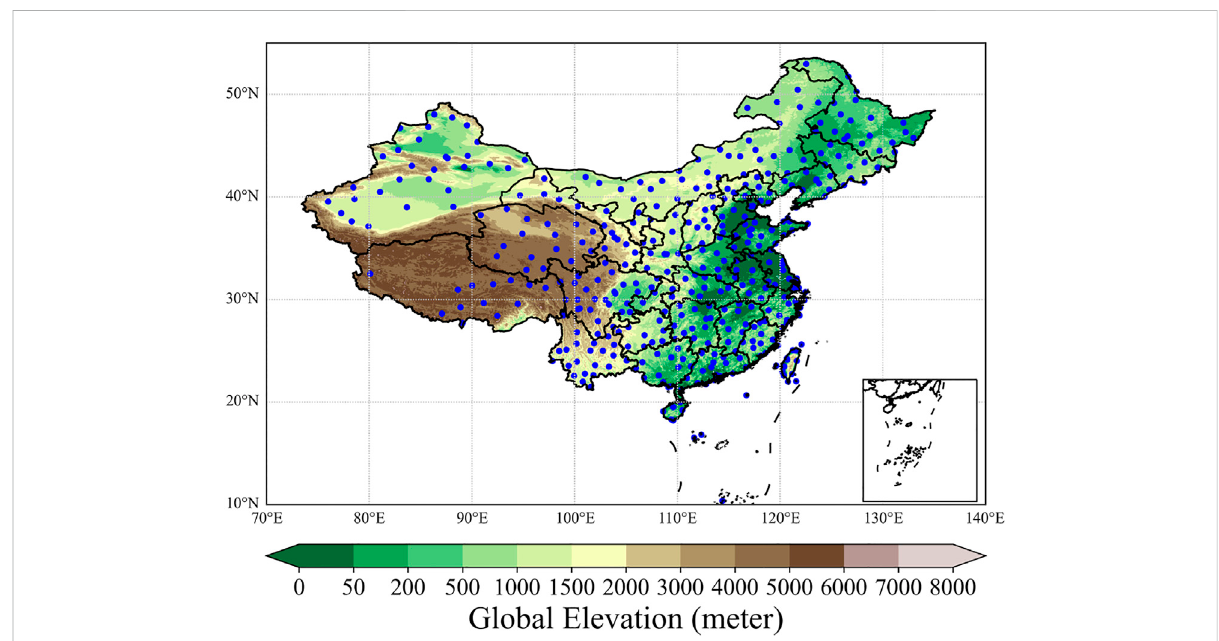
FIGURE 1 Spatial distribution of meteorological stations in China. The blue dots represent the stations.